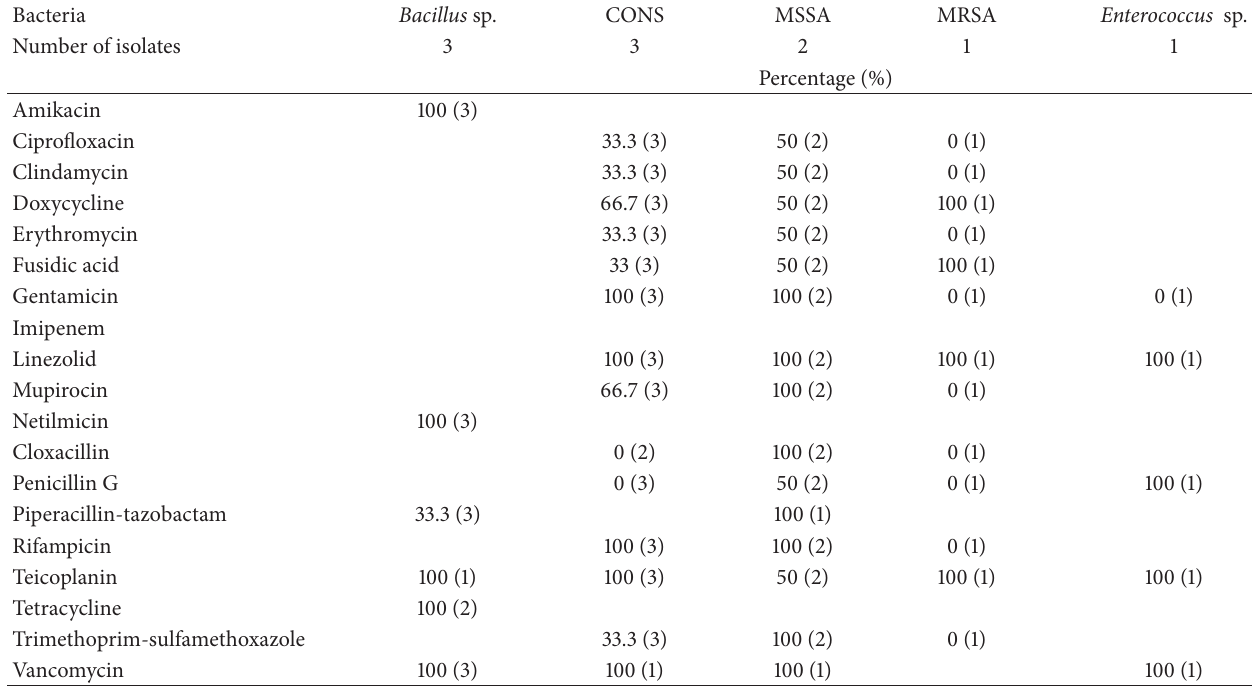
Table 3: Antibiogram for gram-positive bacteria.